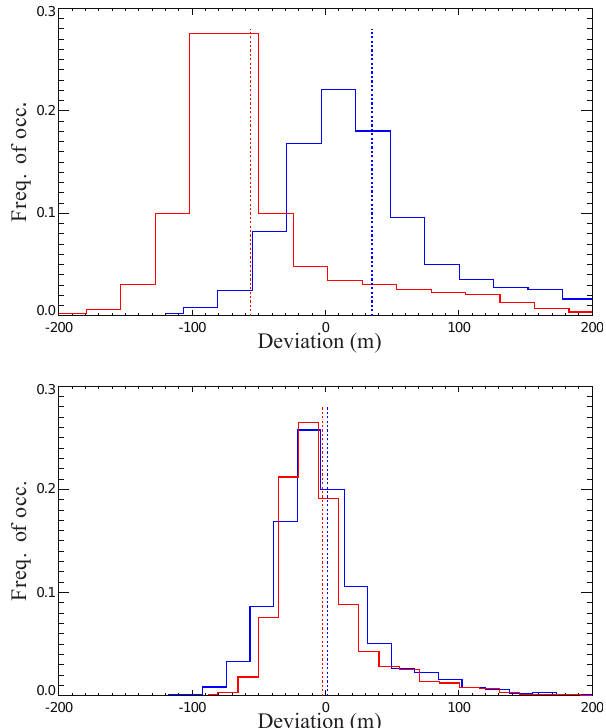
Fig. 8. Histogram of the altimetric deviations between the projected ground echoes and the reference DEM provided by Swisstopo: before pointing correction (top) and after (bottom). The red histogram corresponds to Position 1, the blue one to Position 2. The vertical dashed lines indicate the mean values.